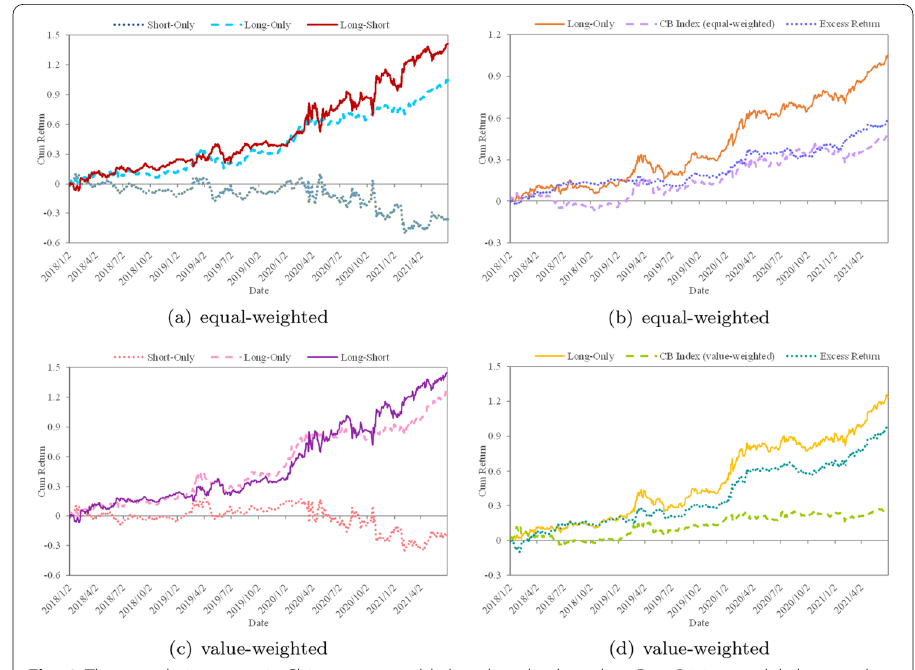
Fig. 6 The cumulative return in Chinese convertible bond market based on DeepPricing model, the sample period is from January 01, 2018 through June 30,